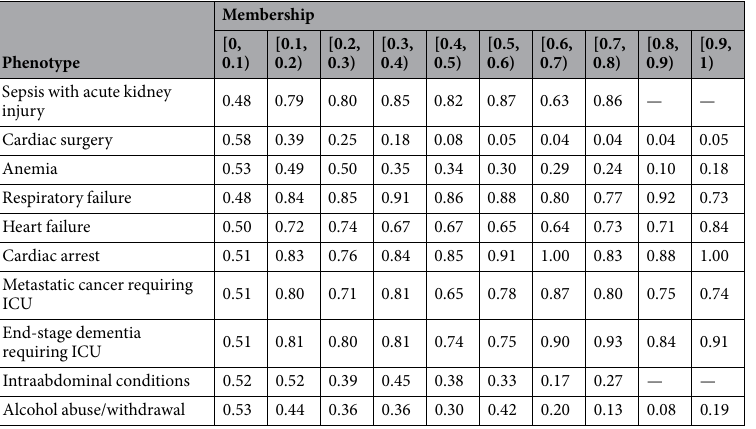
Table 5. Patient’s mortality distribution. The distribution is computed as the number of patients who died/the total number of patients whose membership value is in the range. Empty values when the number of patients < 10. Note that our dataset contained half patients who died and half patients who